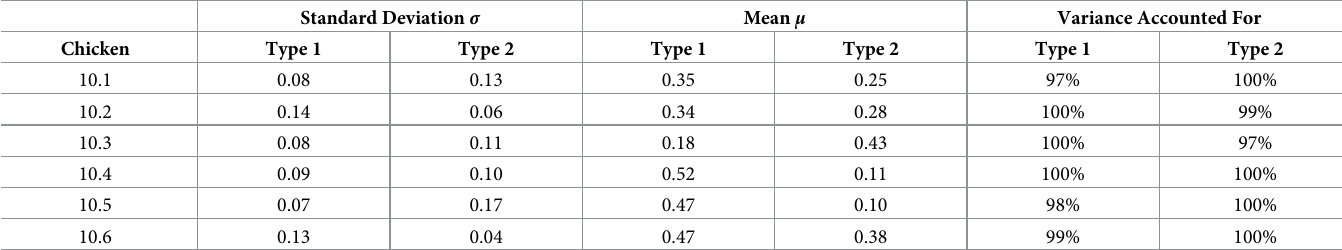
Table 1. Parameters from fits of Eq 1 to individual